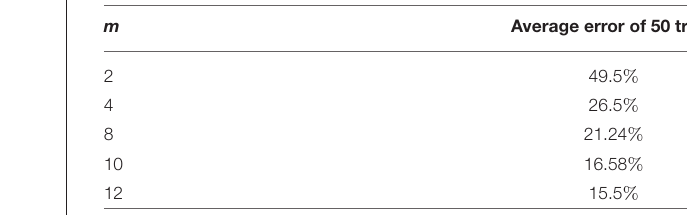
TABLE 3 | Results of testing for “two intersecting circles”